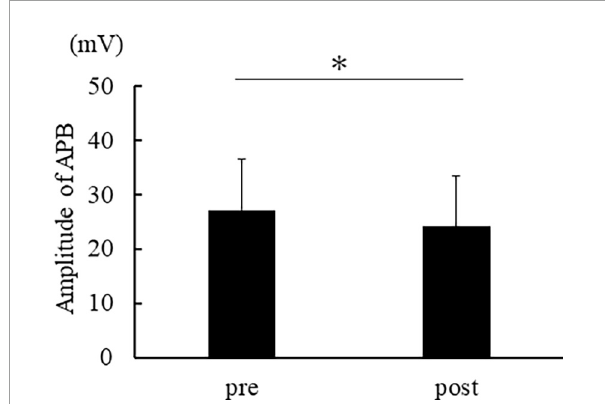
FIGURE3 The average of APB muscle activation. The error bar indicates the standard deviation. Asterisks indicate significant differences ( p < 0.05).